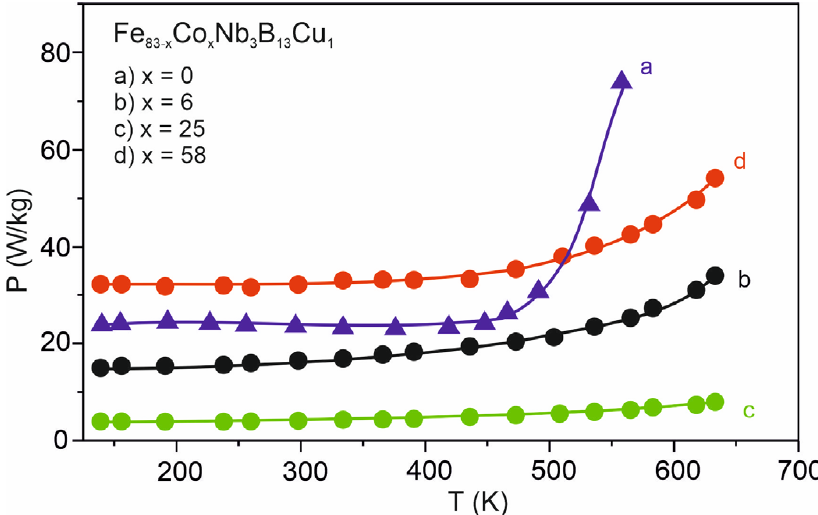
Figure 6. Core losses (P) as a function of temperature for Fe 83 − x Co x Nb 3 B 13 Cu 1 (x = 0 (a), 6 (b), 25 (c), and 58 (d)) alloys annealed at 750 K for 10 min.